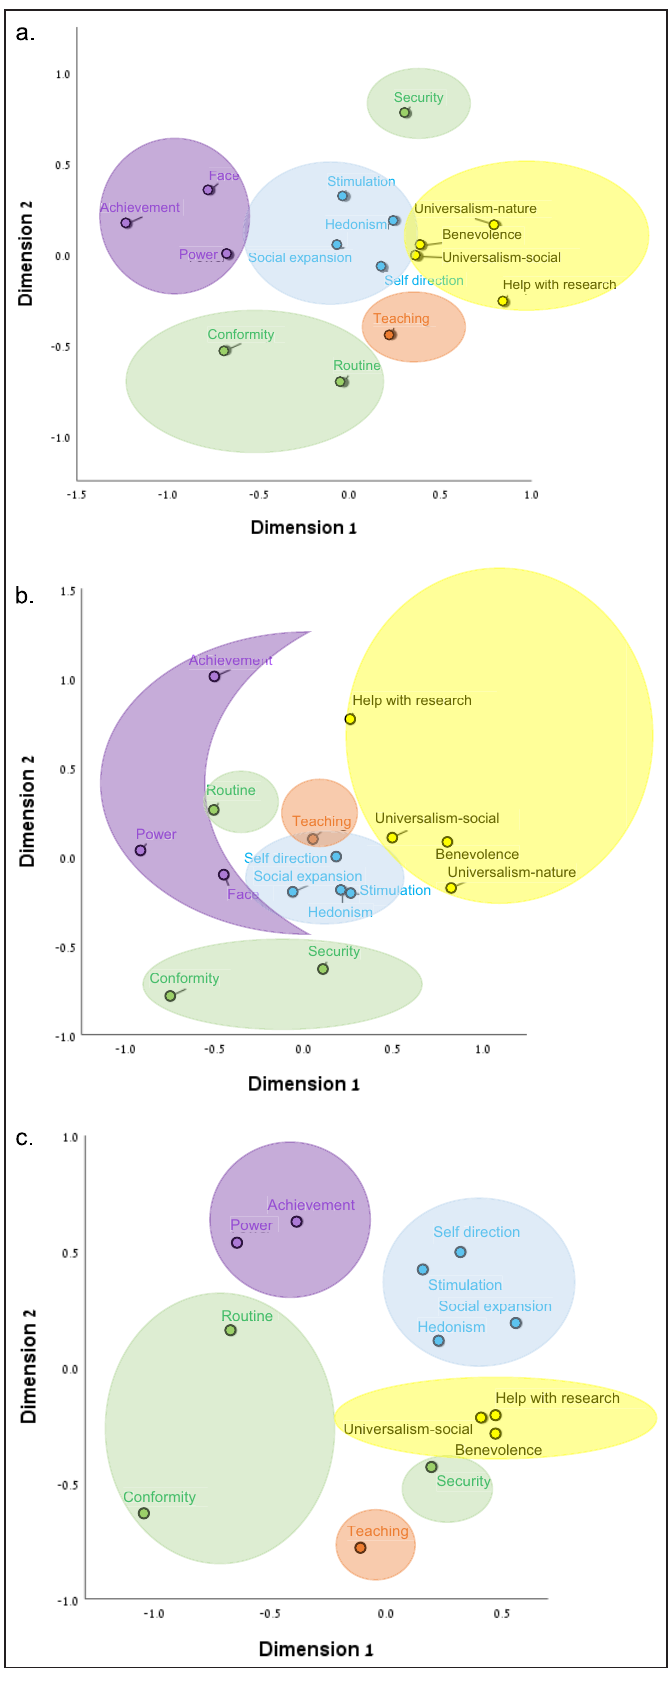
Figure 2 Results of multidimensional scaling (MDS) analyses of citizen science motivations in a two-dimensional space for sample 1, ( a ) backyard nature observation; for sample 2, ( b ) bird counting; and for sample 3, ( c ) quality-of-life